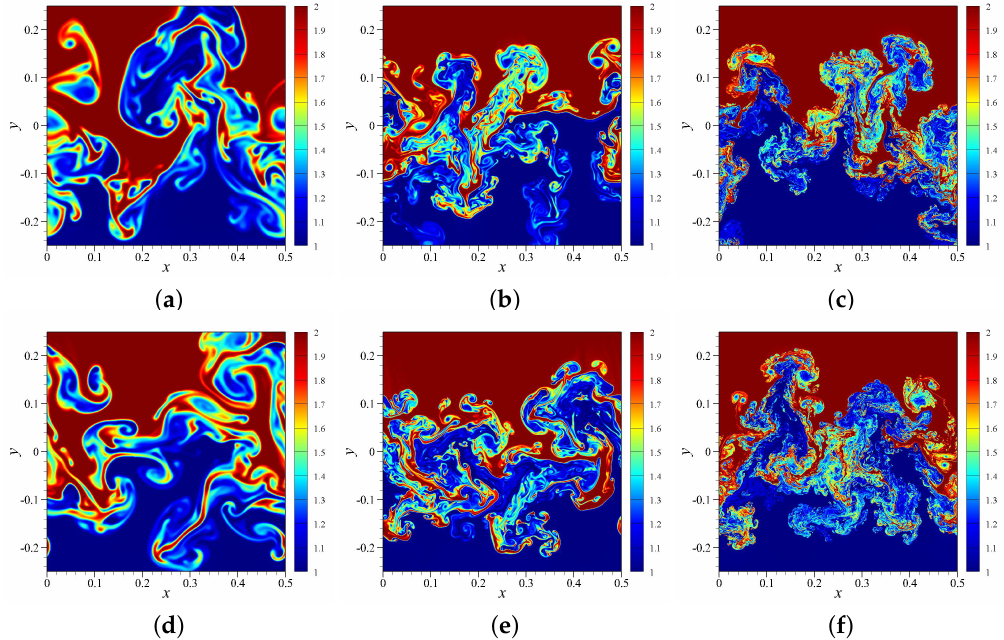
Figure 5. Density contours for the RTI problem with multi-mode perturbation at t = 4.0 for different coarse grid resolutions and filtering strength, σ of CS+RF schemes: ( a ) σ = 1.0 with 256 × 384 resolution; ( b ) σ = 1.0 with 1024 × 1536 resolution; ( c ) σ = 1.0 with 4096 × 6144 resolution; ( d ) σ = 0.4 with 256 × 384 resolution; ( e ) σ = 0.4 with 1024 × 1536 resolution; ( f ) σ = 0.4 with 4096 × 6144 resolution. The gravity is directed in a vertically downward